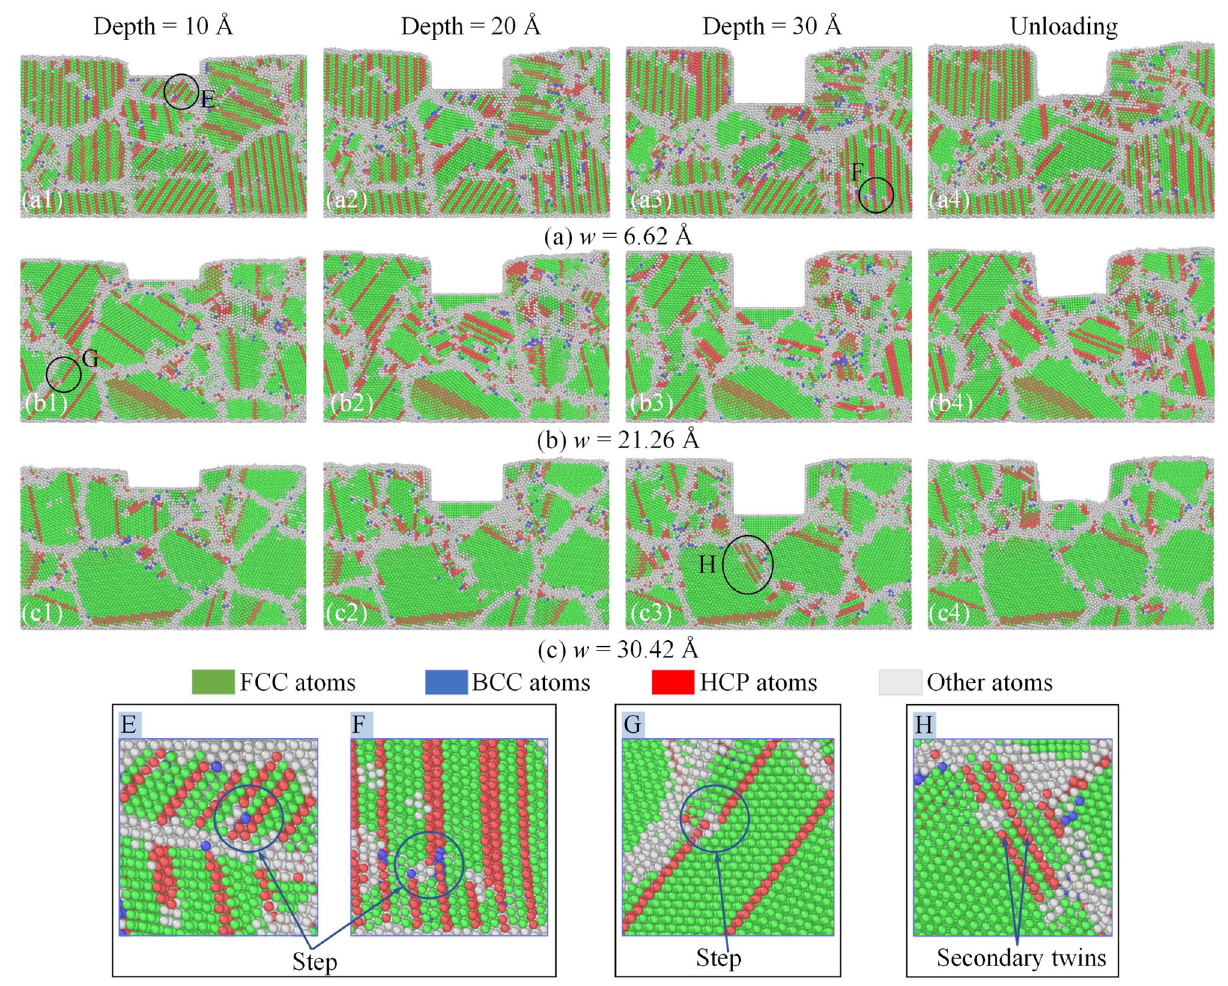
Figure 14. The microstructure snapshots at the different imprinting depths and the unloading stage for the NT-polycrystalline structure of the Al0.5 HEA with various TB distances: 6.61 Å ( a ); 21.26 Å ( b ); and 30.42 Å ( c